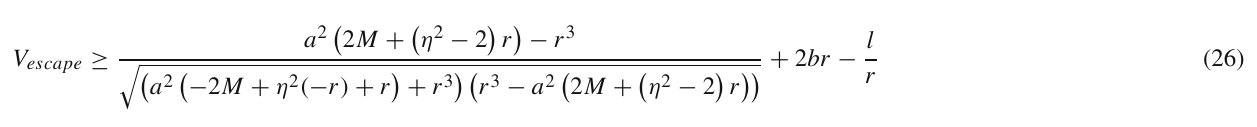
The Eq. (25) shows the time of a particle moving in an orbit around a BH. In general, time to stay in an orbit around the BH is finite. The time will become infinite if angular momentum is equal to magnetic field, (cid:14) = b . In the absence of magnetic field T becomes infinite for (cid:14) = 0. If the angular momentum is zero then orbits becomes static. It is very less likely that (cid:14) becomes equal to b even if the radius of the orbit is